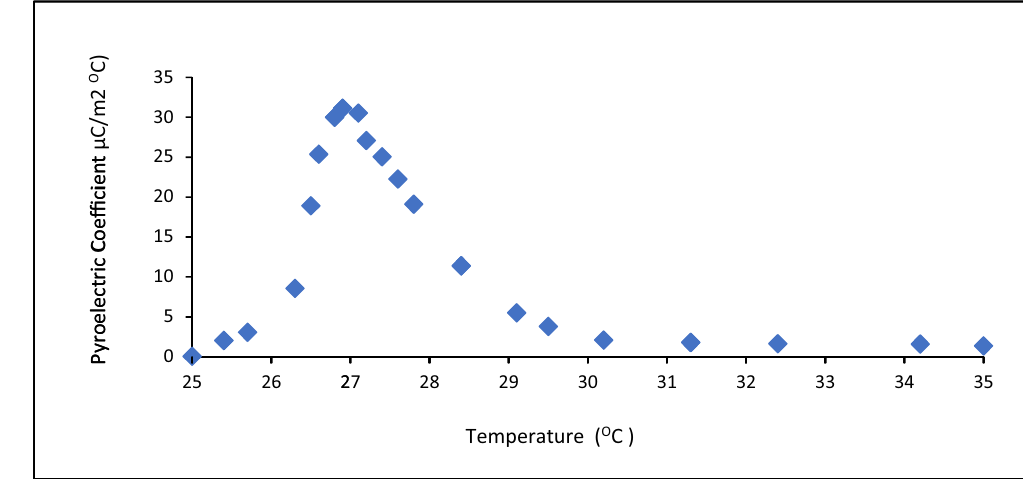
Figure 17: Pyroelectric Coe ffi cient versus the change of